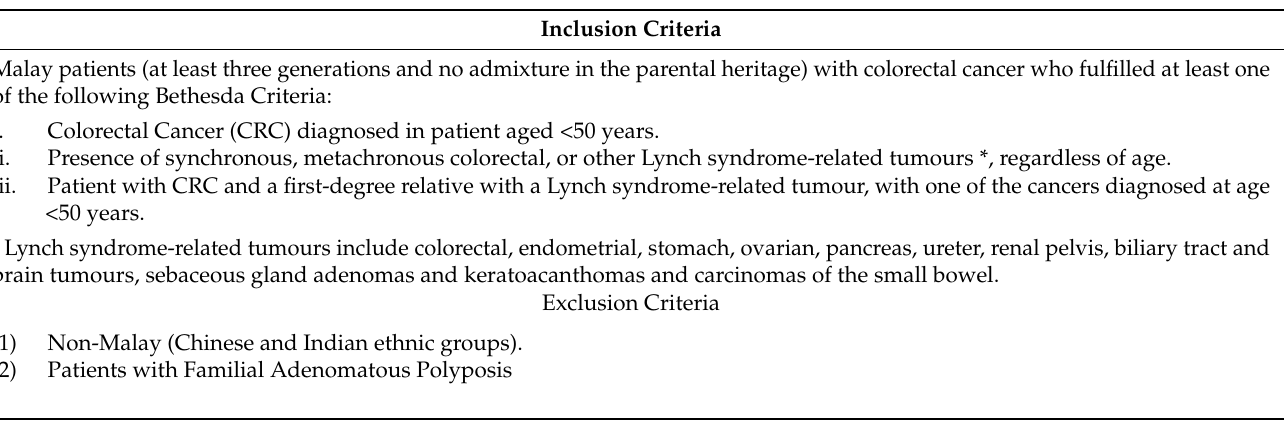
Table 1. Inclusion and exclusion criteria for the selection of the patients. Inclusion